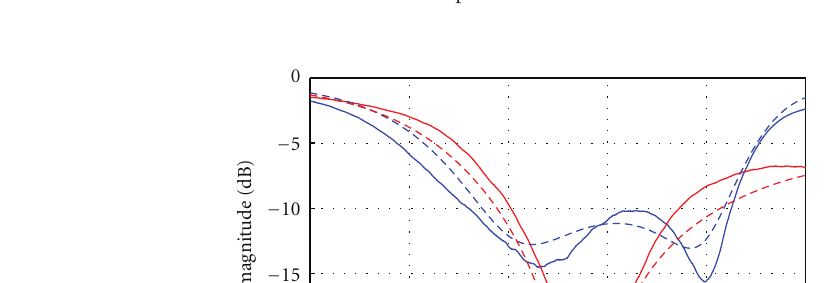
Figure 5: Compact multiantenna for WiMax.